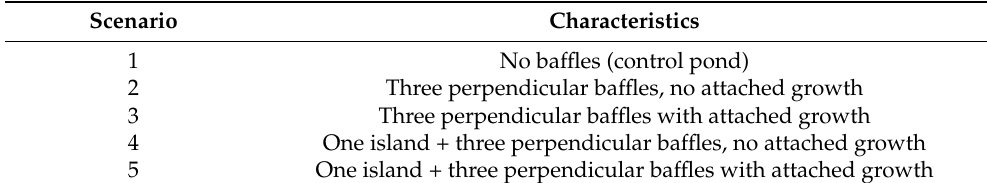
Table 1. BOD removal scenarios for the application of kinetic model of Pond 2. Some of the scenarios are derived from Coggins et al.